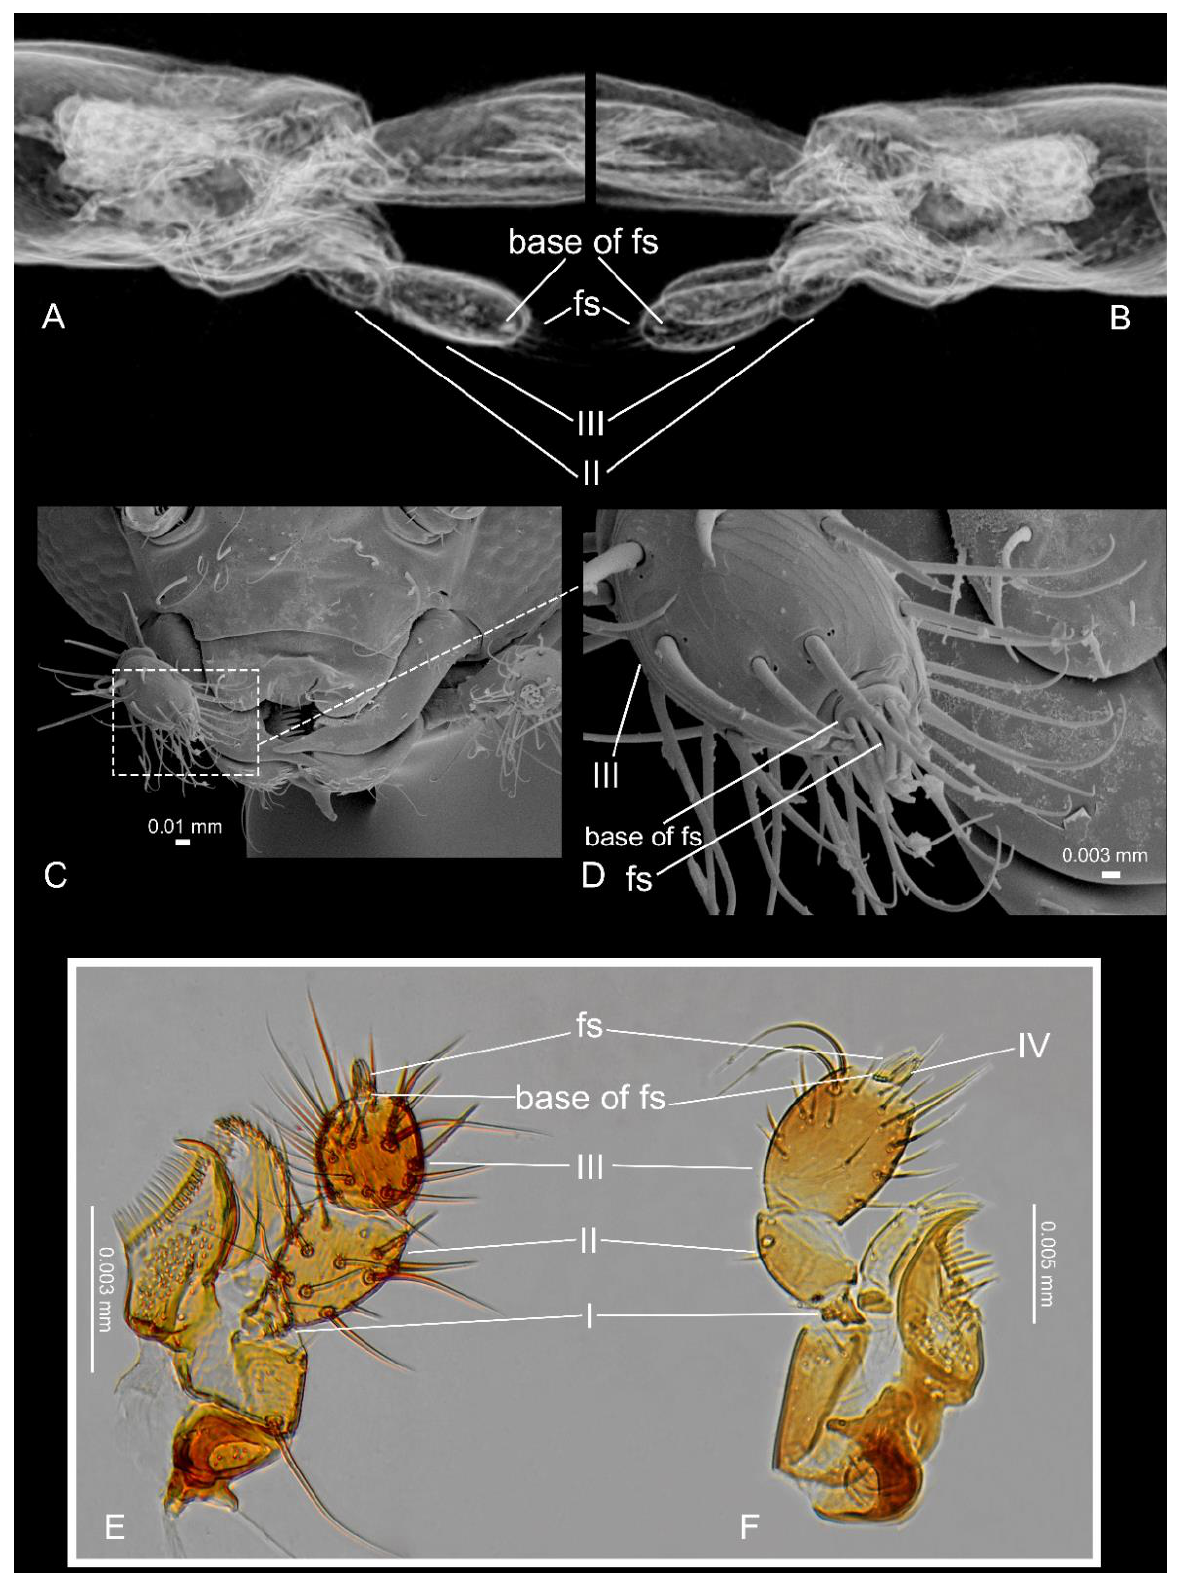
Figure 3. Pareburniola dominicana gen. et sp. nov. Head, in lateral view: right ( A ), left ( B ); Corotoca pseudomelantho Zilberman, 2020. Head, in frontal view: ( C ), maxillary palp and filamentous sensillae ( D ), whole maxilla ( E ); Thyreoxenus solomonensis Seevers, 1937. Maxilla ( F ). fs = filamentous sensillae.